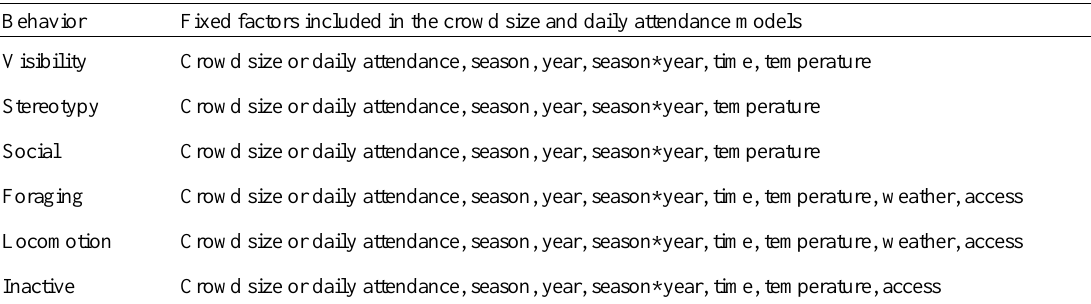
Fixed Factors Included in All GLMMs for Bear Behavior Behavior Fixed factors included in the crowd size and daily attendance models